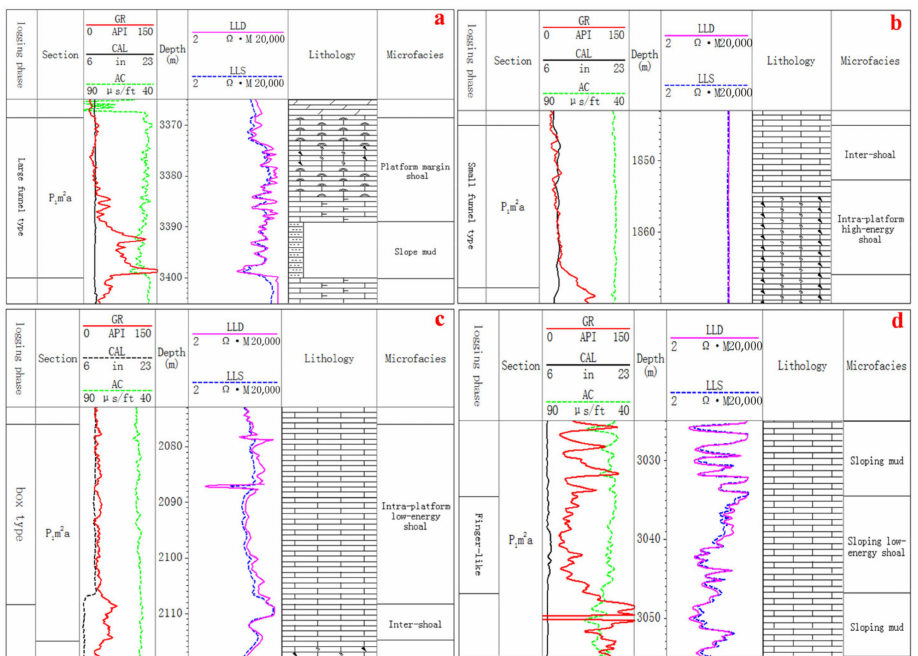
Figure 6. Logging facies pattern diagrams of different shoal facies deposits in Eastern Sichuan. ( a ) Large funnel-type, platform margin shoal in well Chi12. ( b ) Small funnel-type, high-energy shoal in well Xiang14. ( c ) Box-type, low-energy shoal in well Cao14. ( d ) Finger-like, sloping low-energy shoal in well